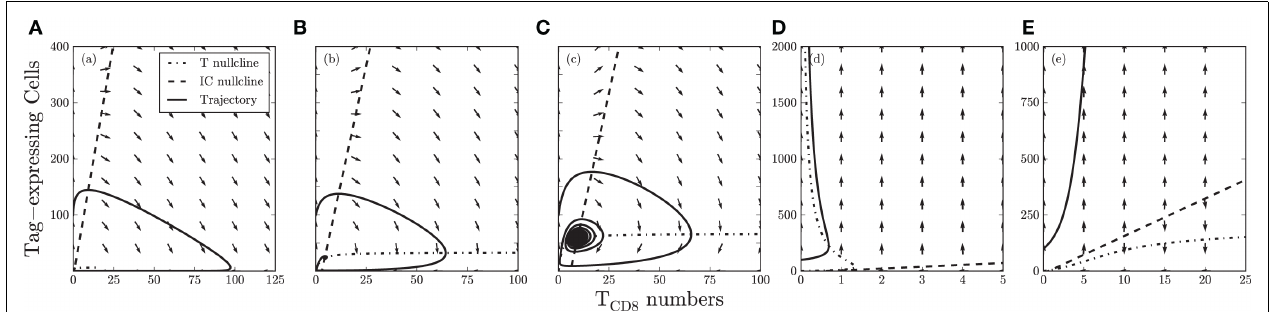
FIGUREA2 |The behaviors from FigureA1 are shown in phase space. Light gray arrows indicate the directional field, and the nullclines indicate boundaries between positive and negative horizontal or vertical components of the directional field. Intersections of the nullclines indicate steady states of the system.